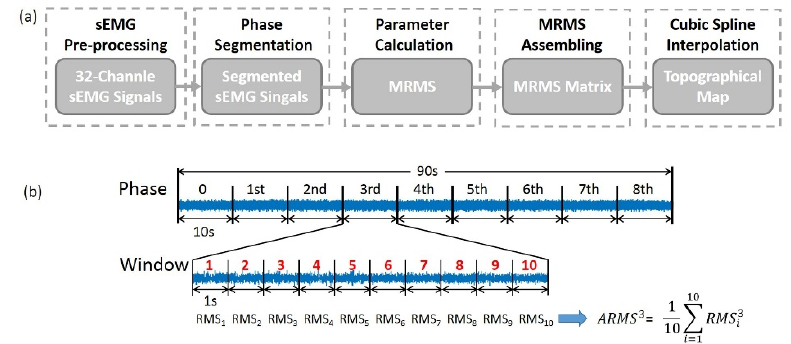
Figure 2. ( a ) Block diagram of topographical maps generation. ( b ) Example of averaged RMS calculated for the 3rd phase.